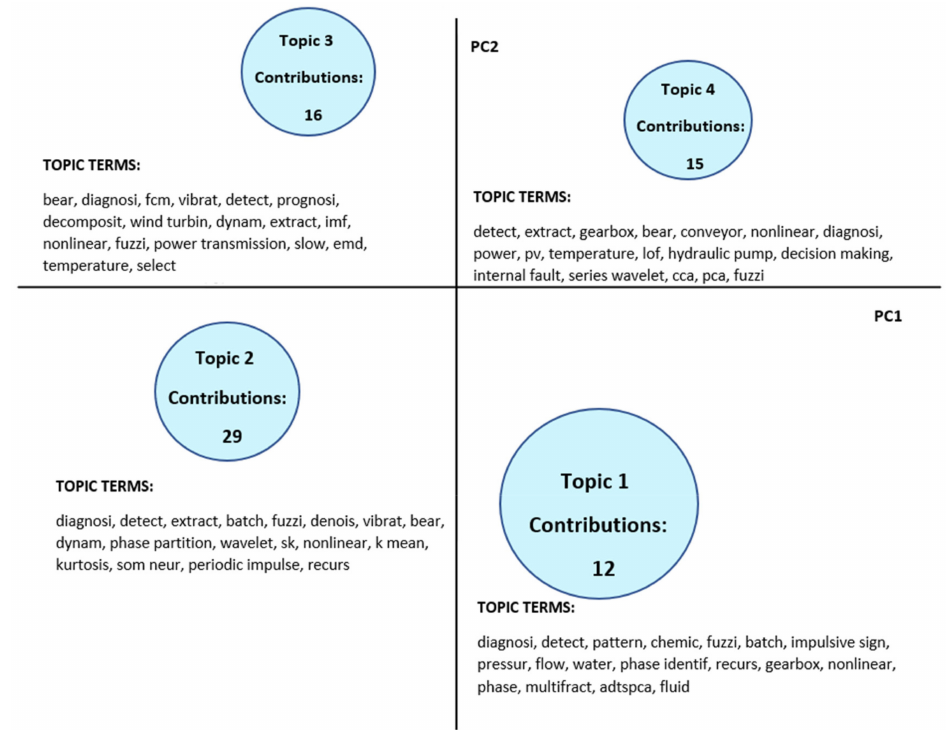
Figure 6. Topics